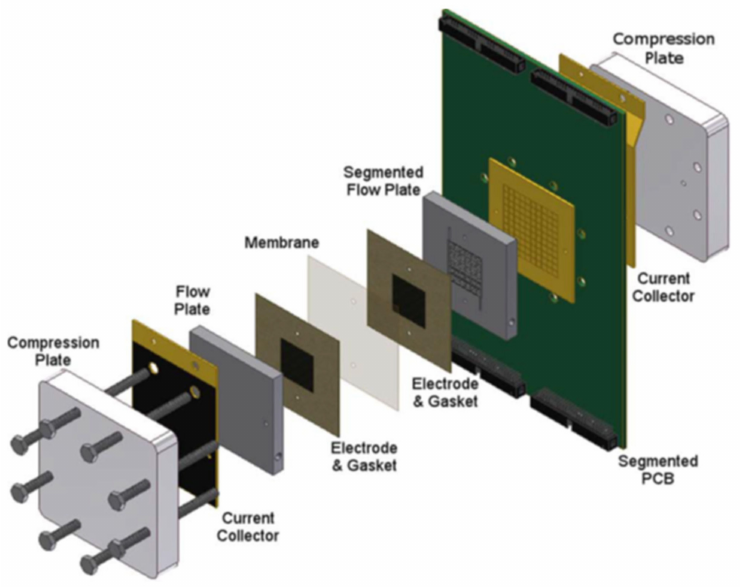
Figure 9. Arrangement of the PCB in a cell for the measurement of local current or voltage (repro- duced from ref [97]).